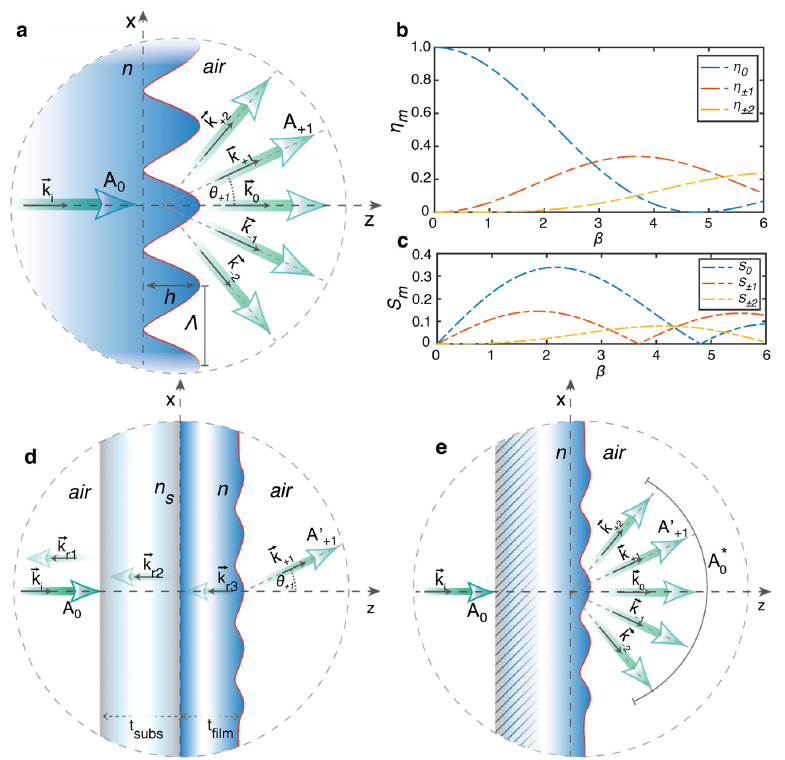
Figure 1. Diffraction behavior of an ideal sinusoidal surface relief grating within the scalar diffrac- tion theory. ( a ) Scheme of the sinusoidal grating boundary at the interface of the infinite